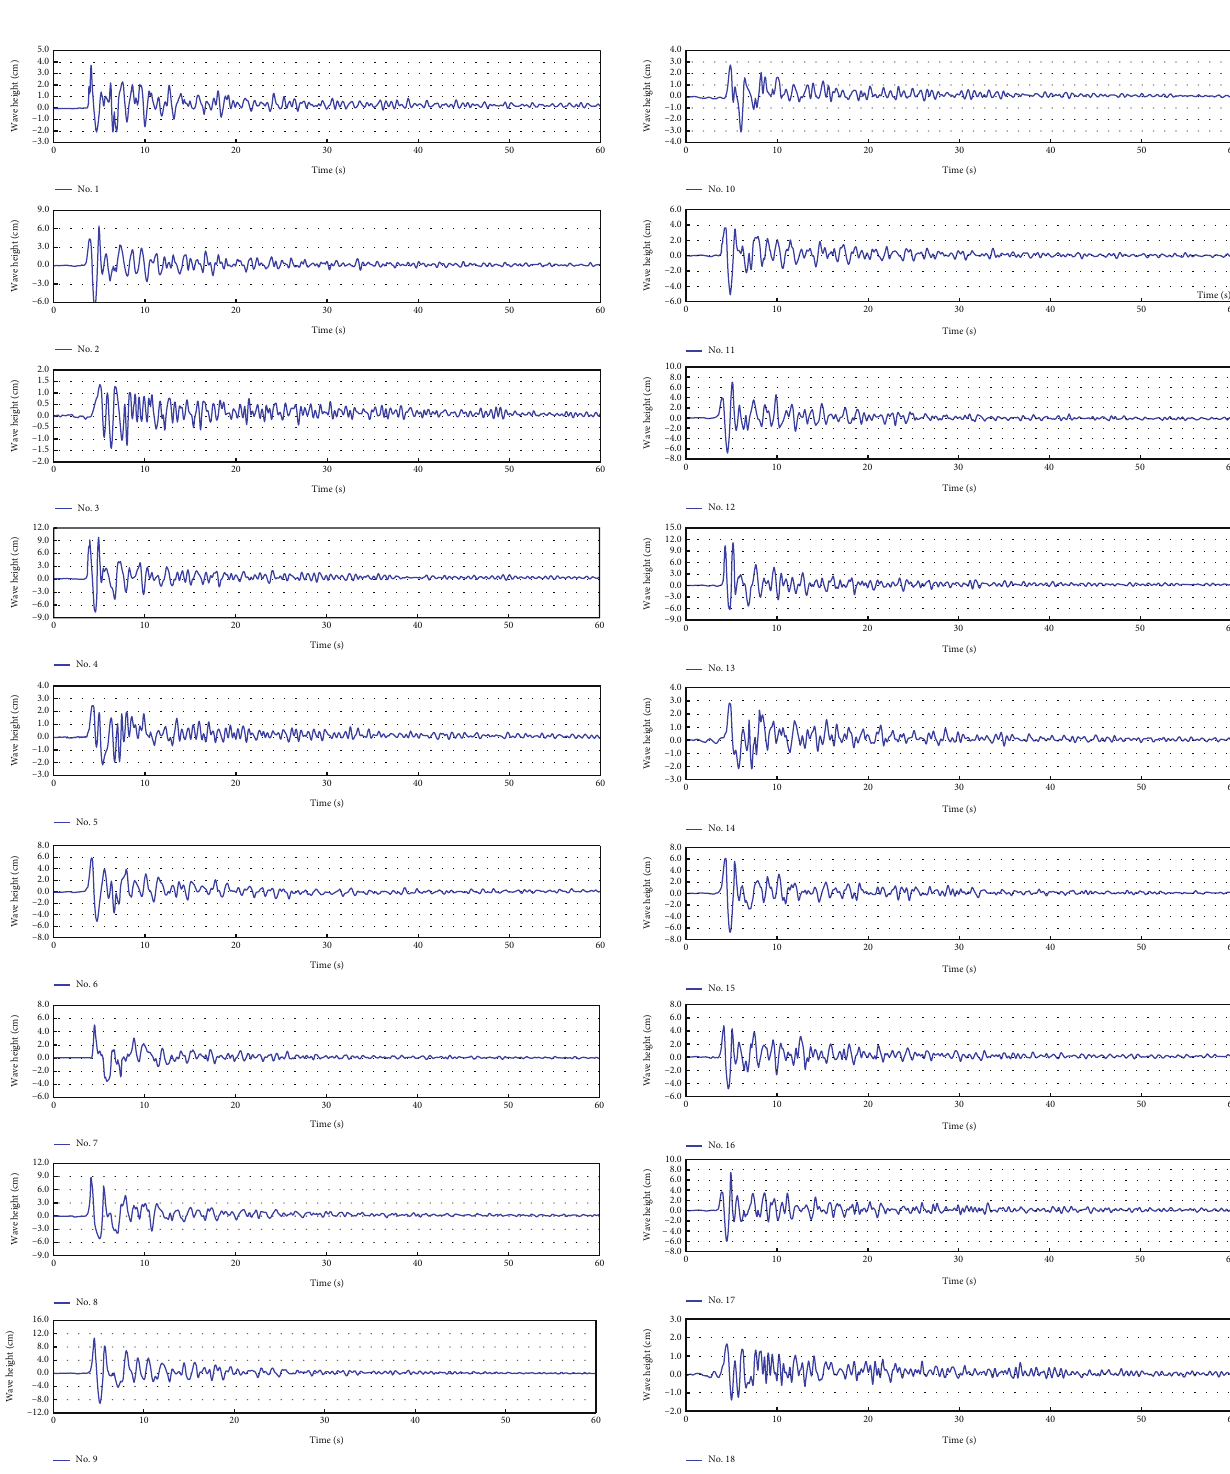
Figure 5: Time history curves of 18 groups of wave amplitudes measured by wave height gauge no.